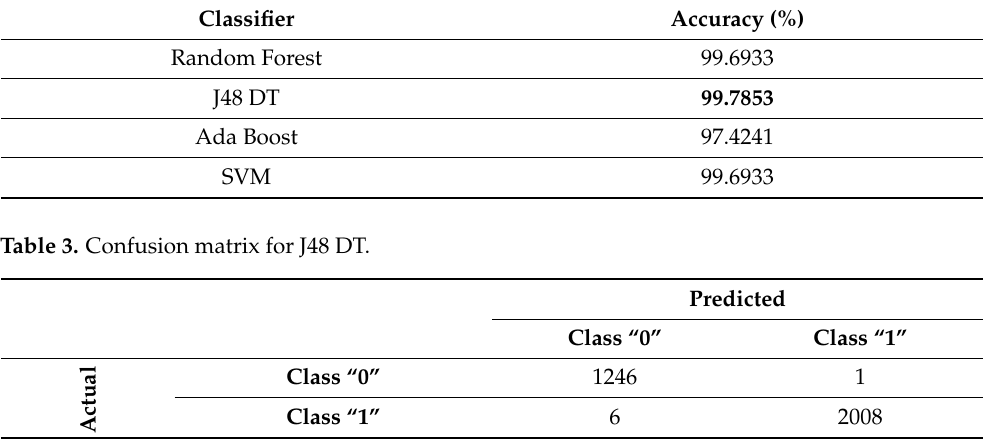
Table 2. Comparative results for the classifiers.